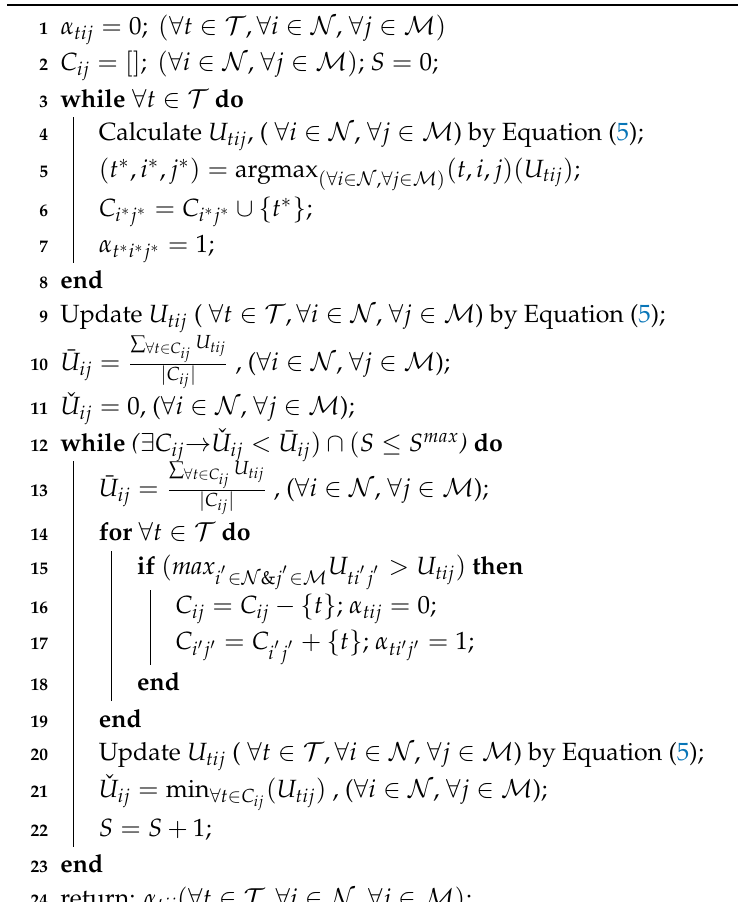
Algorithm 1: The PE-based Algorithm for personal incentive